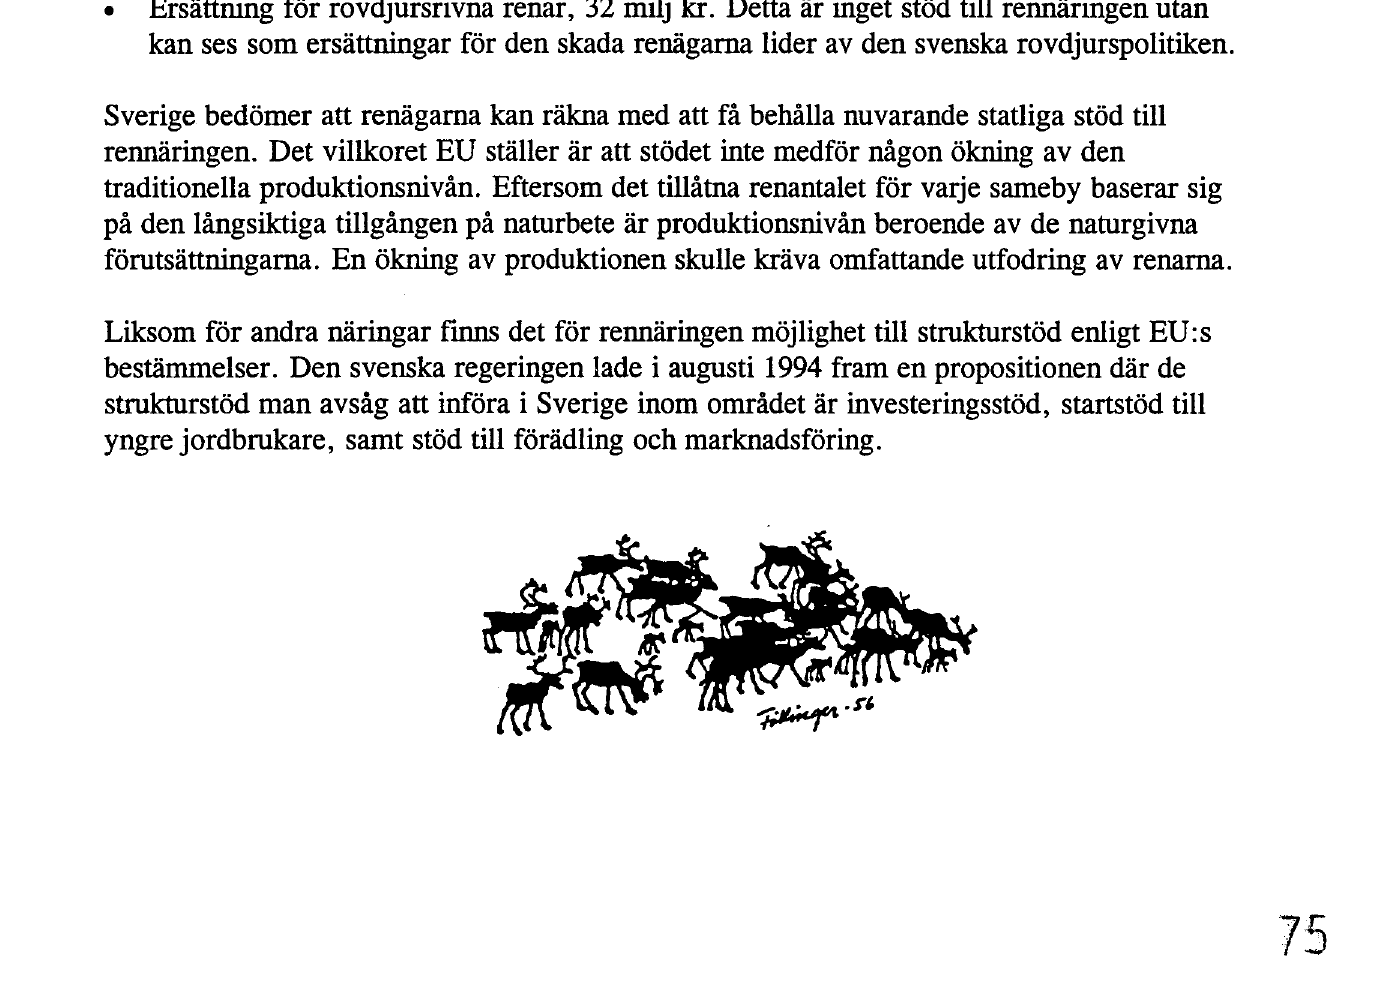
I EU:s gemensamma jordbrukspolitik betraktas renkott som en jordbruksprodukt. EU har